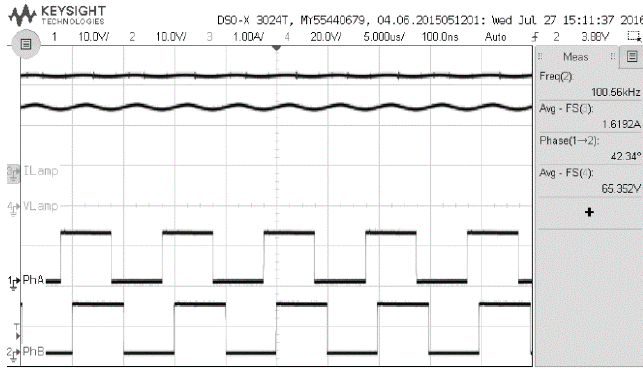
Figure 13. Lamp current, lamp voltage and control signals in steady state.